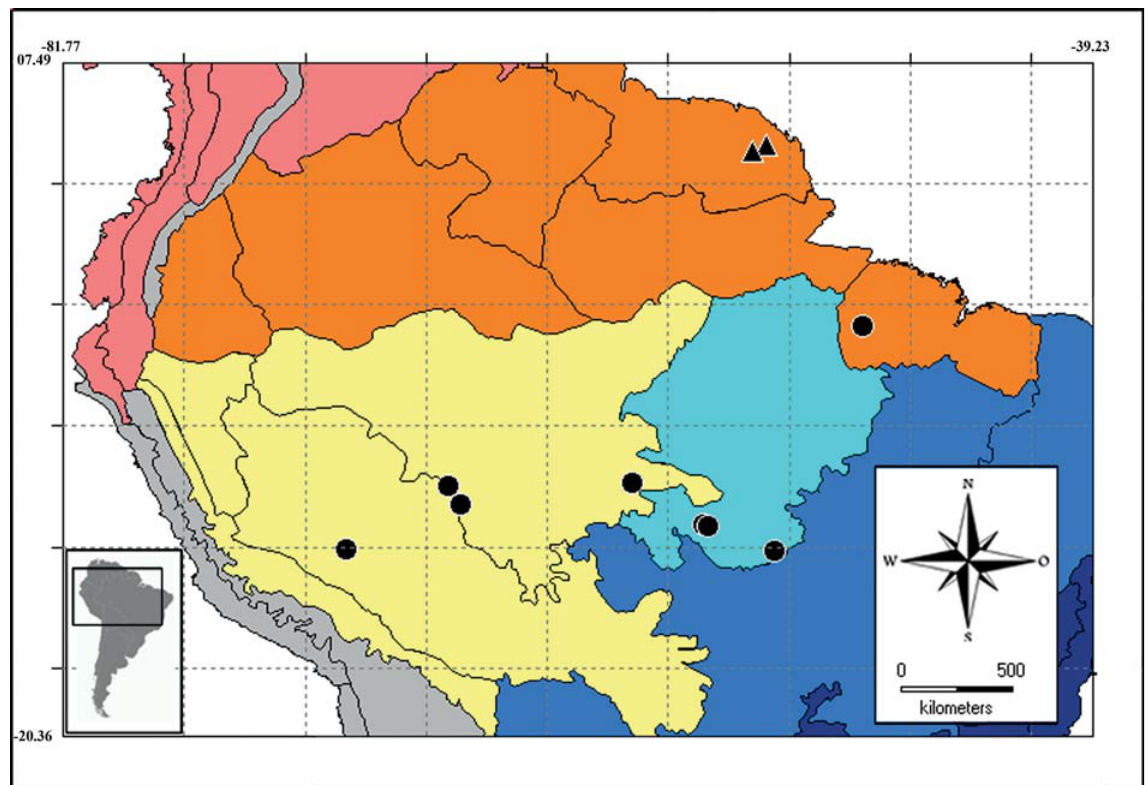
Fig. 9. Geographical distribution of Canthidium stofeli sp. nov. (circles) and Canthidium feeri sp. nov.